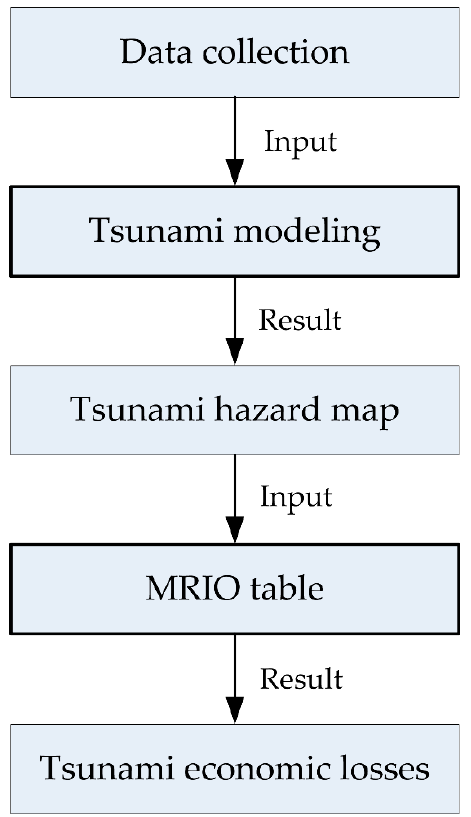
Figure 2. Stream line of this study used to achieve tsunami economic losses.